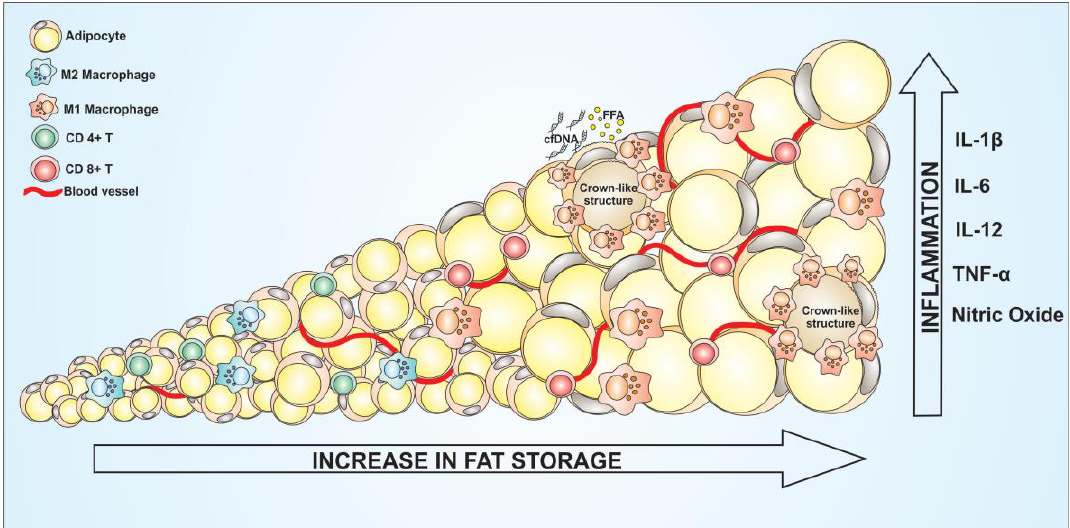
Figure 4. Increased lipid reserve in white adipocytes can favor inflammation. The imbalance in the energy reserve in fat cells leading to obesity is capable of mediating inflammation in tissue. Adipose tissue hypertrophy and hyperplasia can induce increase in vascularization, facilitating the recruitment of immune cells. Due to the secretion of various inflammatory mediators in a deregulated form in obese adipose tissues, there is an increasing polarization of immune cells to their pro inflammatory profile. The number of macrophages recruited into obese adipose tissue increases as well as its polarization to the M1 profile. Once polarized, macrophages are able to form crown-like structures (CLS) around adipocytes in the degeneration process, inducing their death with the release of cytoplasmic components into the extra cellular environment, this fact increases inflammation in the tissue, where more macrophages will be recruited and polarized. The release of cell-free DNA (cfDNA) by necrotic adipocytes increases the macrophages recruitment, which will then be polarized. In addition, the release of free fatty acids (FFA) may favor the development of some metabolic diseases such as cancer. Unlike healthy tissue, where a larger macrophage population is found in its M2 profile and CD4+ T cells maintaining tissue homeostasis, the obese tissue has an increased presence of CD8+ T cells, favoring the inflammatory process.